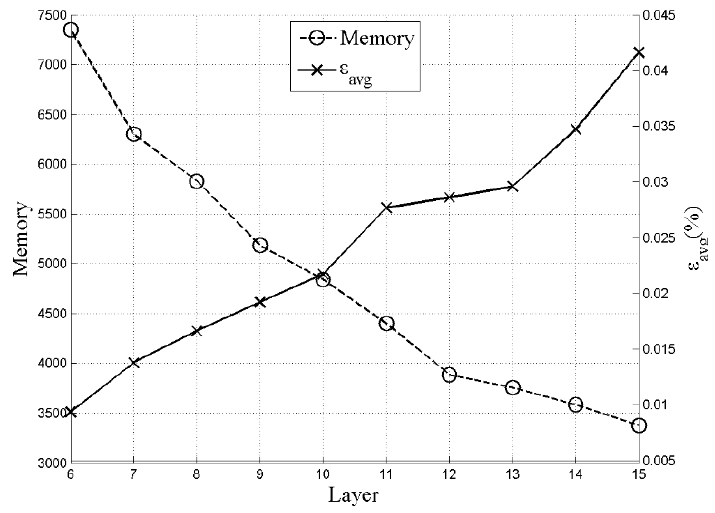
Figure 6. Relationship between memory and errors.